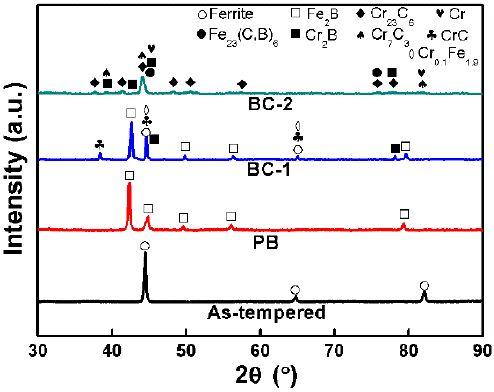
Figure 2. X-ray diffraction (XRD) patterns of the AISI 5140 steel after PB, BC-1, and BC-2 treatments. Figure 2. X-ray di ff raction (XRD) patterns of the AISI 5140 steel after PB, BC-1, and BC-2